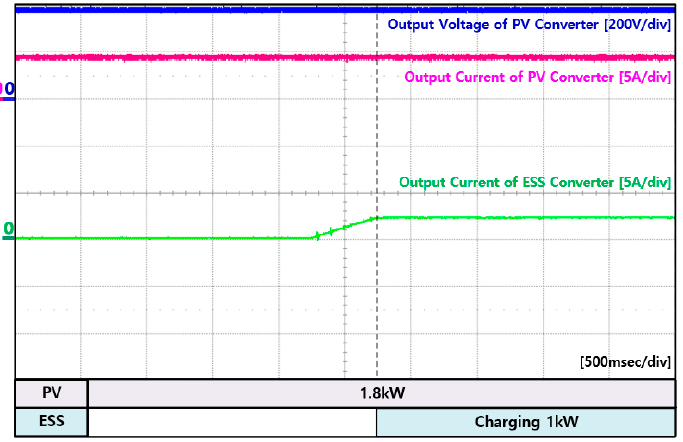
Figure 12. Experiment waveforms of DC load and multi-level inverter in mode 1.